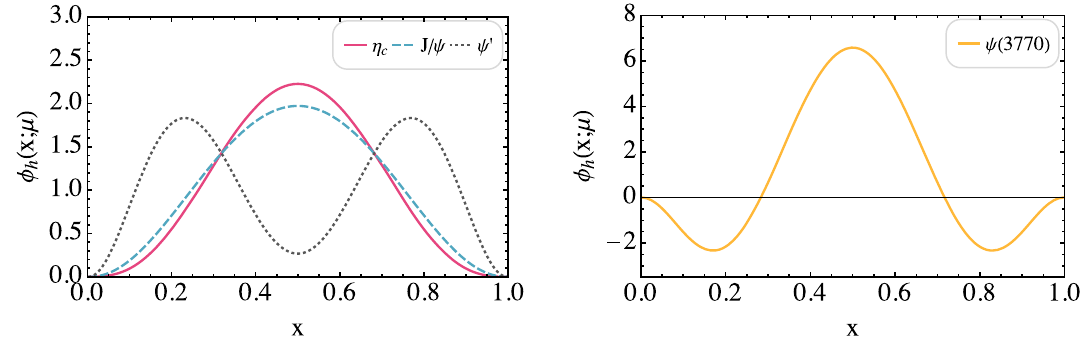
Fig. 12 Quark distribution amplitudes of η c , J /ψ , ψ (cid:2) , and ψ( 3770 ) calculated according to Eq.